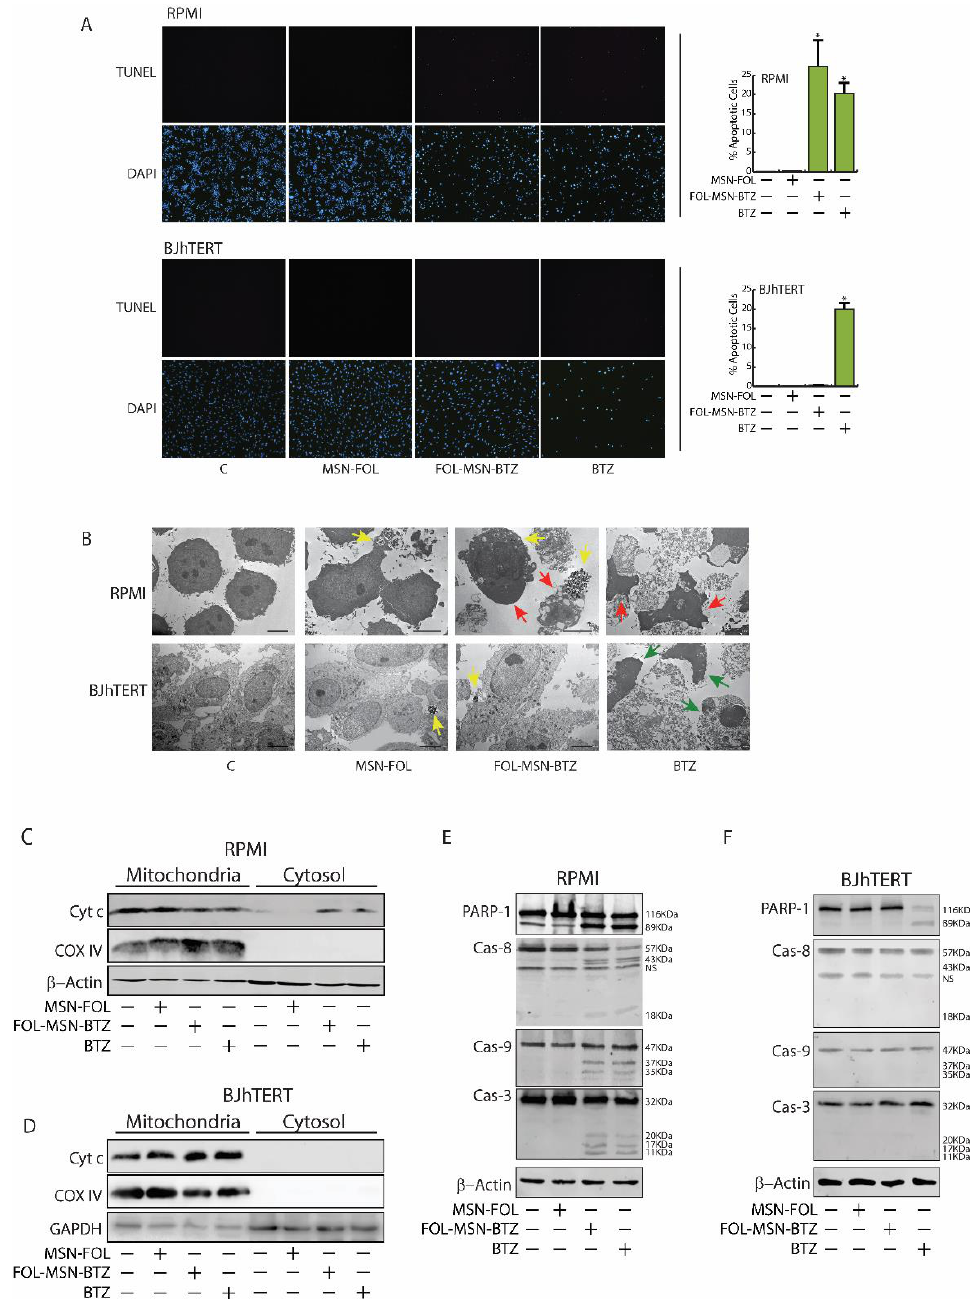
Figure 2. BTZ is not toxic to normal cells when bound to targeted MSNs. ( A ) RPMI-8226 (RPMI) and BJhTERT were treated or not (control) with MSN-FOL, FOL-MSN-BTZ and free BTZ for 1 h and processed for TUNEL assay after 36 h. Nuclei were counterstained with DAPI. Cells were photographed at 10× magnification, and apoptotic cells from triplicate experiments were counted using Image J software (graphs on the right). (*) p < 0.05 vs. control. ( B ) A duplicate set of cells was processed for TEM analysis (see Materials and Methods ). Red arrows: apoptotic cells; green arrows: parthanatic cell death; yellow arrows: MSNs. Scale bars 5 μm, × 2000 magnification. ( C – F ) Molecular profile of BTZ-induced death in MM cells and in BJhTERT cells line. A third set of both cell lines was treated as in ( A , B ), and cytosolic and mitochondrial fractions ( C , D ) or total proteins ( E , F ) were extracted and subjected to WB analysis to assess the expression of the indicated apoptotic markers. β -Actin and GAPDH were used as loading control; COX IV: mitochondrial marker to assess fractionation quality. NS: Non-Specific bands.